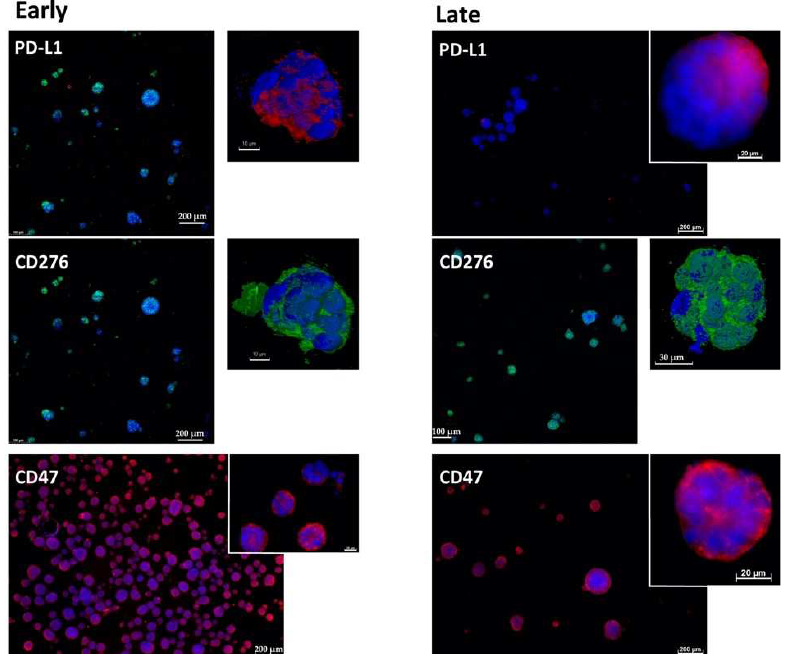
Figure 2. Expression of immune checkpoint antigens on BCO#154 organoids. Organoids of BCO#154, a population with moderate in vitro growth capacity, were fixed and directly stained in early passage ( left panel ) or in later passage ( right panel ) cultures with antibodies reactive with PD-L1, CD276, and CD47 as indicated. For each staining, an overview with several organoids and a detailed picture of individual organoids are presented. Size bars indicate 200 μm, 100 μm, 20 μm, and 10 μm as indicated.